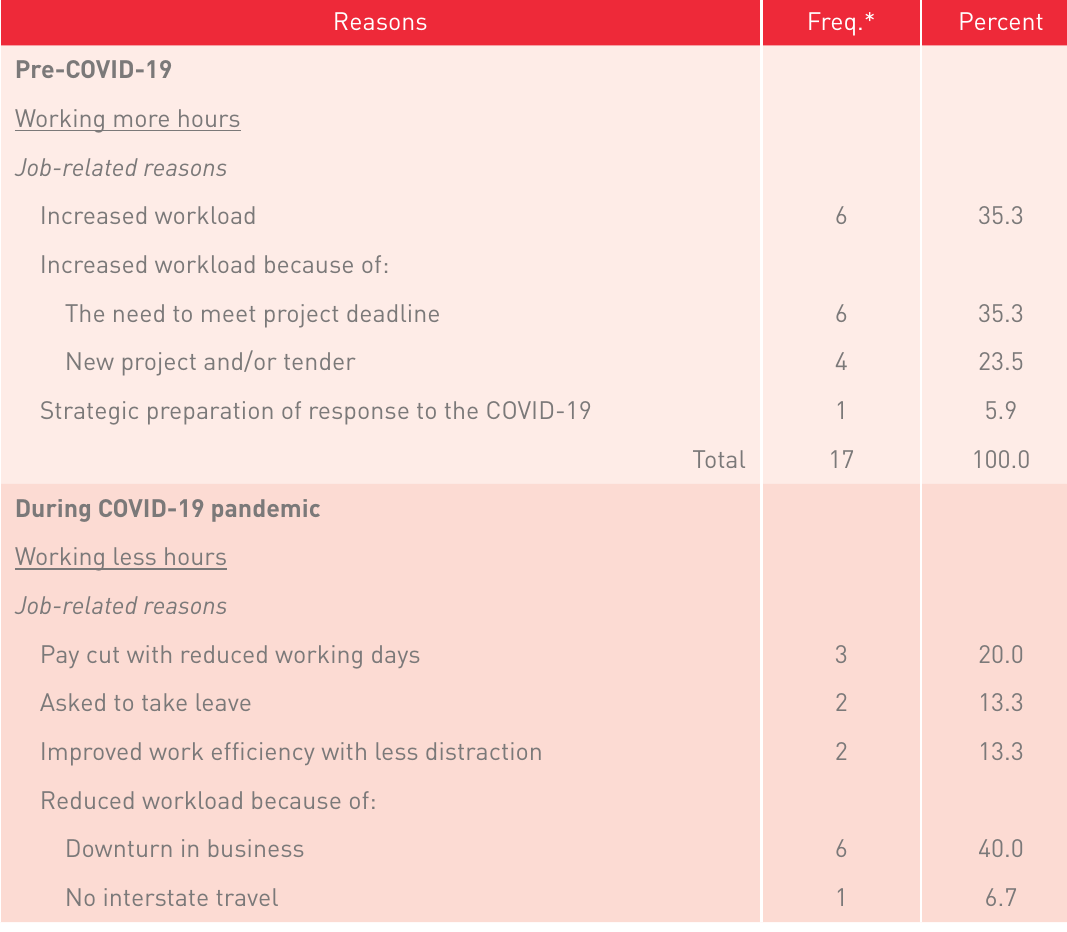
The reasons why the respondents had been required to work less (or more) hours than usual pre- and during the COVID-19 pandemic time periods Reasons Freq.* Percent